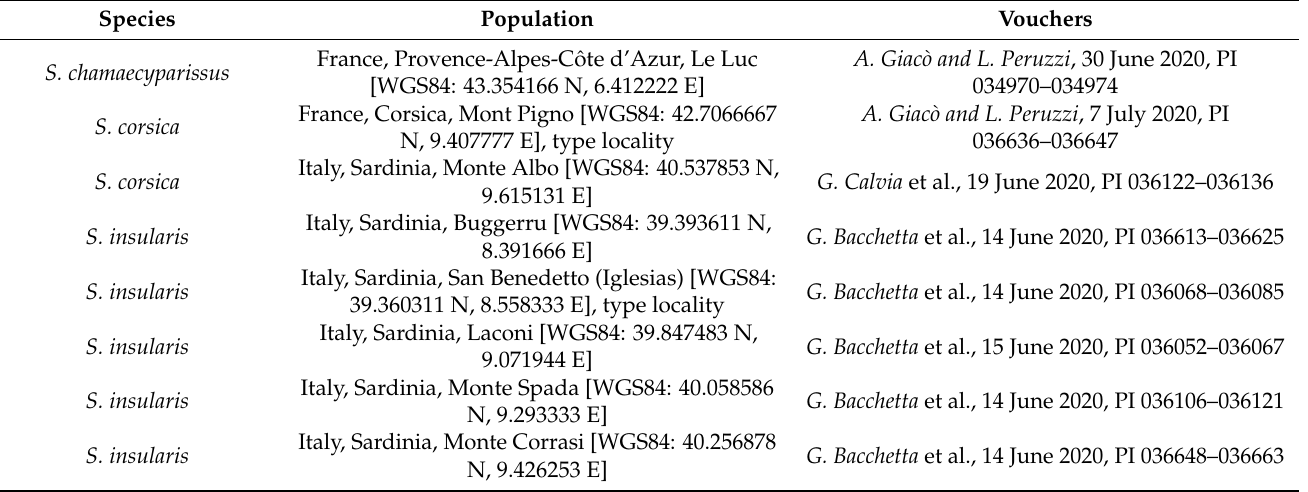
Table 1. Sampled populations with voucher